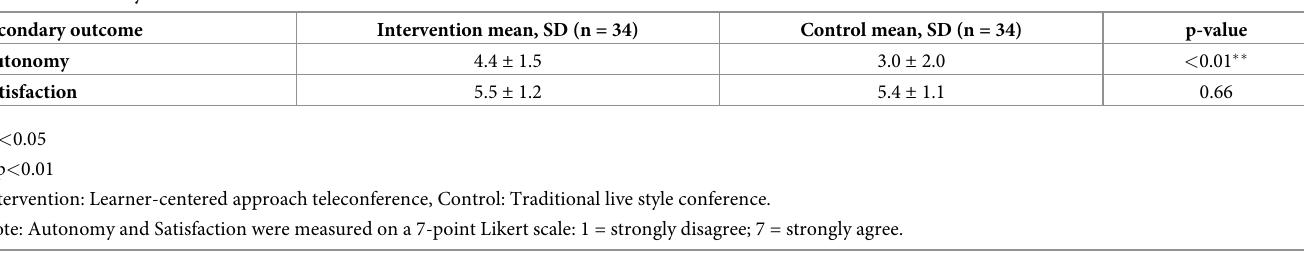
Table 5. Autonomy and satisfaction for both